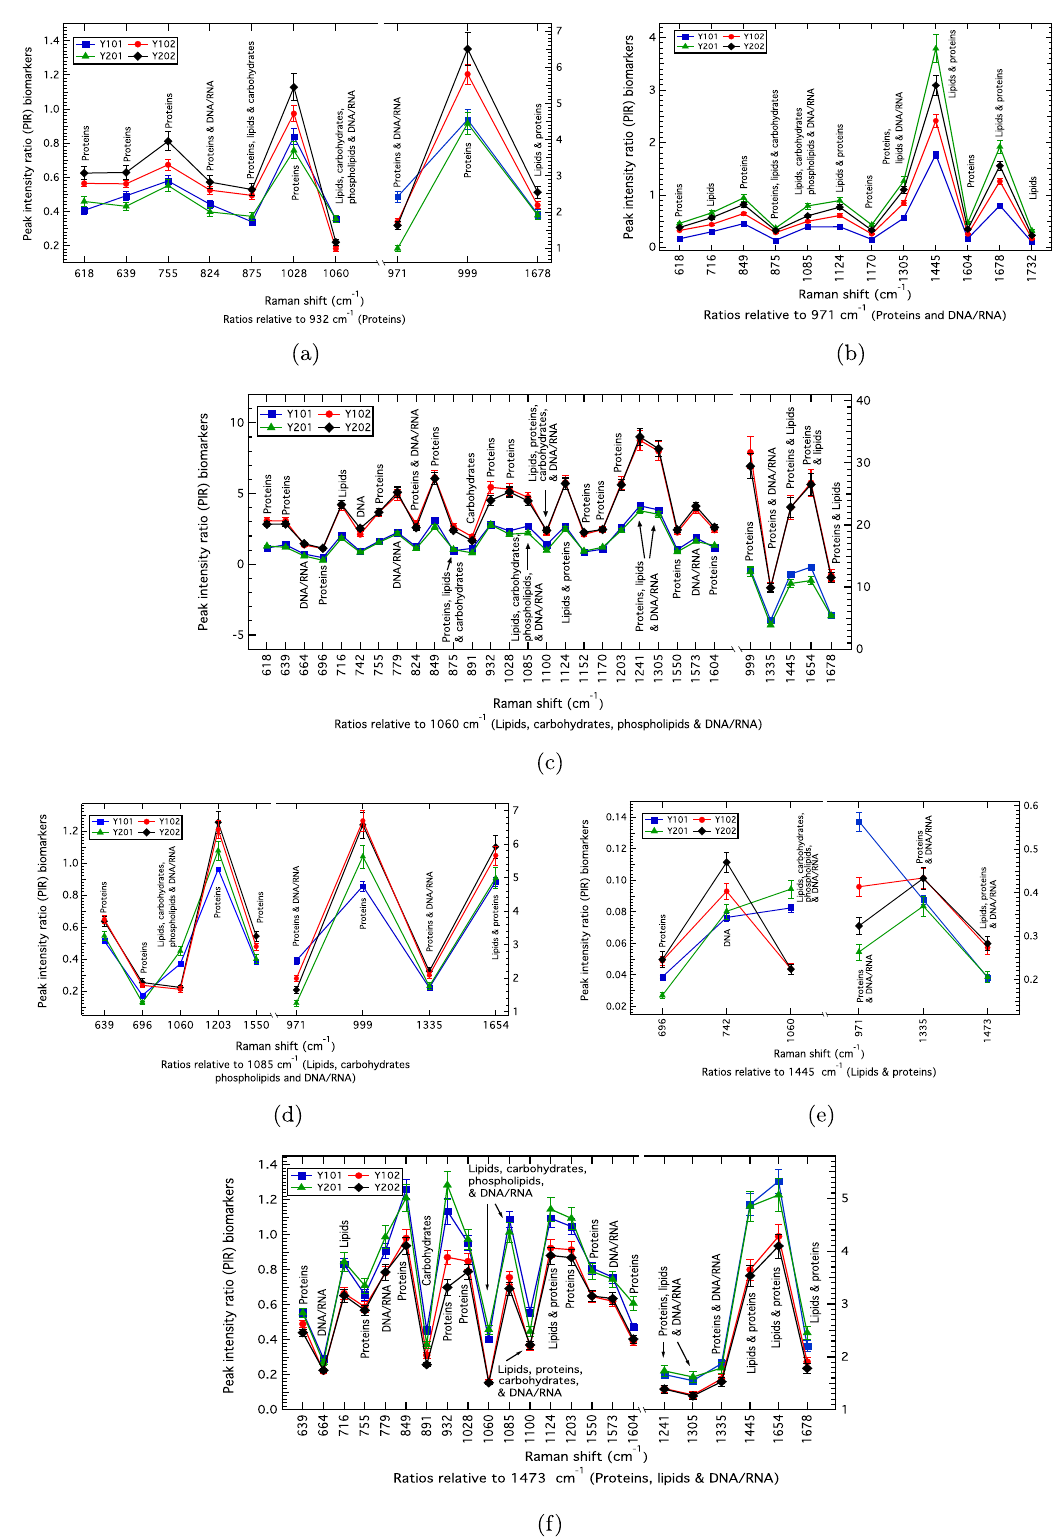
Figure 2. ( a )–( f ) hTERT MSC population comparisons (Raman biomarker panels) for the Y101, Y201, Y102 and Y202 cell-lines showing the PIRs that discriminate the Y101/Y201 differentiating vs. Y102/Y202 non- differentiating cell-types, and identify individual hTERT MSC-lines. The uncertainties are the converged propagated standard error of the mean associated with each PIR